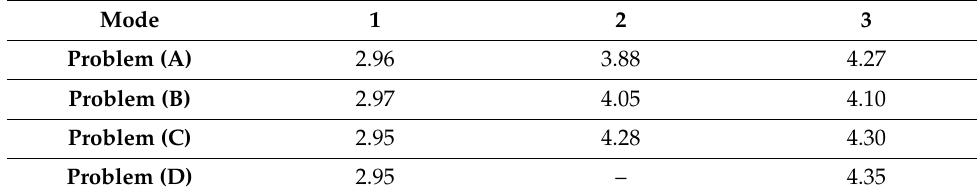
Table 2. Resonant Frequency (GHz) for Four Different Problems.